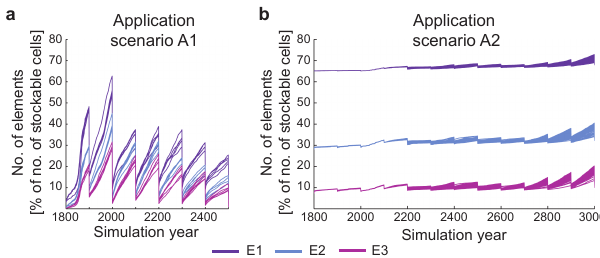
Figure 8. Ratio of the number of elements on the non-spatial layer to cells in the simulation area over time from simulations with all three sets of bioclimate types (E1–E3) and for both application sce- narios (A1: a , A2: b ). For A1 five repetitions using different pseudo- random number streams to extrapolate the bioclimate driver are de- picted; for A2 100 repetitions are shown. The number of elements in A1 simulations increased strongly in between the merging inter- vals with smaller increases in the course of the simulation. For A2 simulations, in contrast, the number of elements increased faster to- wards the end of the simulation time, due to the growing perimeter of the migration front of the tracked species Ostrya carpinifolia (see Supplement Fig.